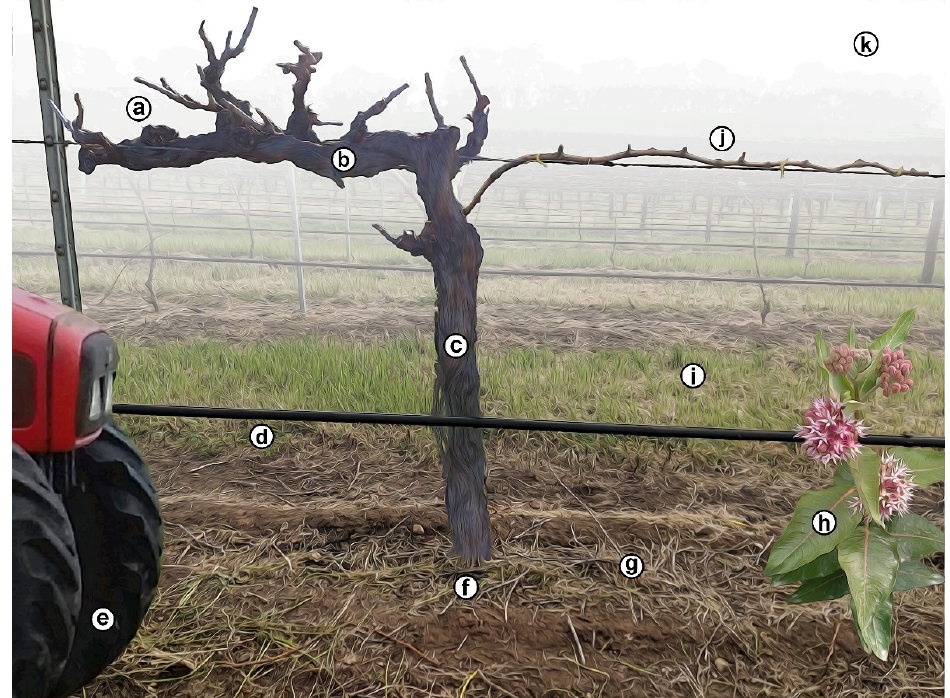
Figure 1. Factors which many have an influence on vineyard longevity. ( a ) Loss of spur positions as a result of mechanical damage, improper pruning, or dieback; ( b ) strangulation of the cordon; ( c ) insufficient carbohydrate reserve storage in perennial organs, or reduced functionality from vascular disease, virus infection, phytoplasma infection, or improper selection of rootstock; ( d ) poor soil water content, or irrigation mismanagement; ( e ) soil compaction; ( f ) soil pathogens including nematodes; ( g ) nutrient mismanagement, or poor soil microbial activity; ( h ) inadequate weed control; ( i ) mismanagement of cover crops and/or insect populations; ( j ) seasonal impacts such as frost damage and major heat events; ( k ) changing climate and weather patterns.